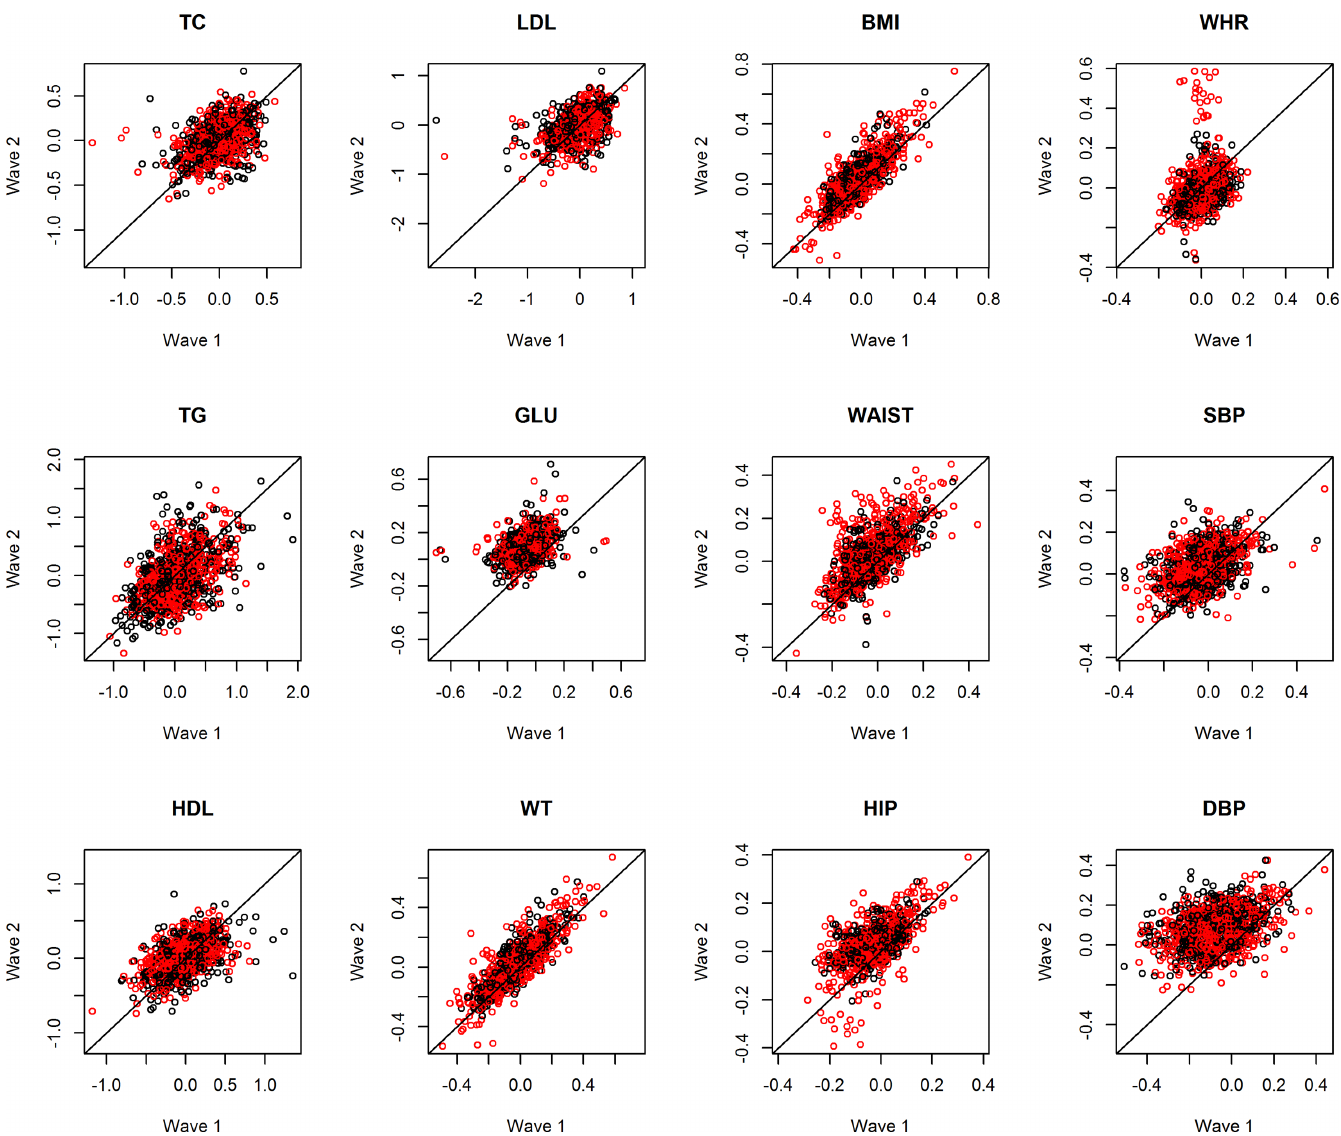
Fig 1. Trend of metabolic phenotypes over time in Danish twins. Scatter plots showing the residuals of phenotype measurement from the mixed effect model at time 1 (horizontal axis) against that at time 2 (vertical axis) for 12 phenotypes in Danish twins (females in red; males in black). TC: total cholesterol; TG: triglycerides; HDL: high density lipoprotein cholesterol; LDL: low density lipoprotein cholesterol; GLU: fasting blood glucose; WT: body weight; BMI: body mass index; WAIST: waist circumference; HIP: hip circumference; WHR: waist-to-hip ratio; SBP: systolic blood pressure; DBP: DP: diastolic blood